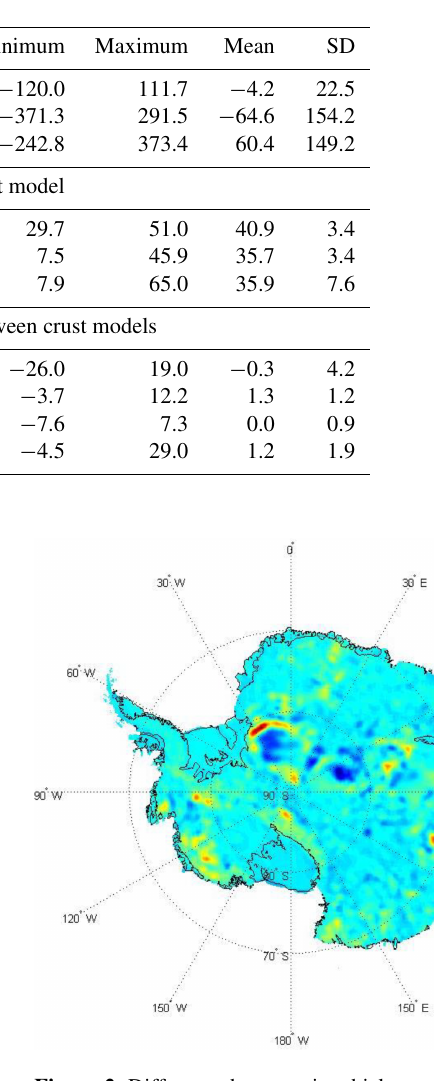
Figure 1. Free air anomalies in milligals (mGal) from the GOCE DIR5 solution.